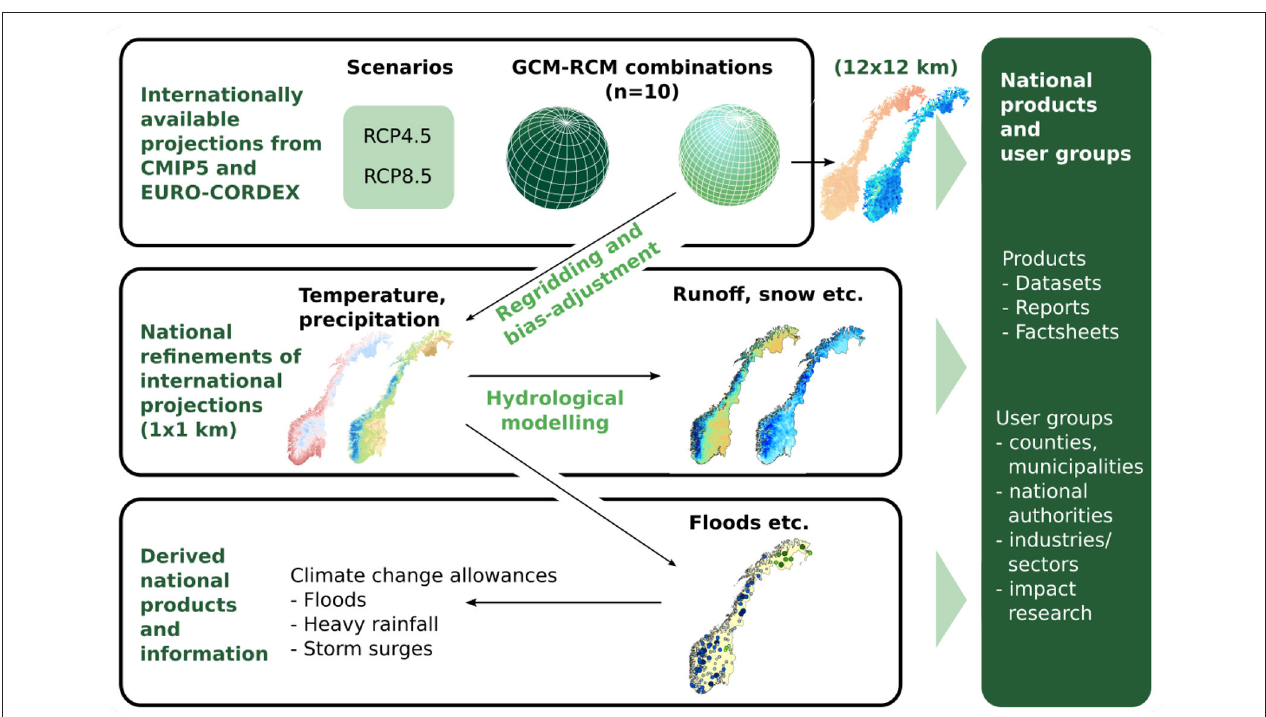
FIGURE 1 | Modeling chain from climate model output to climate information.